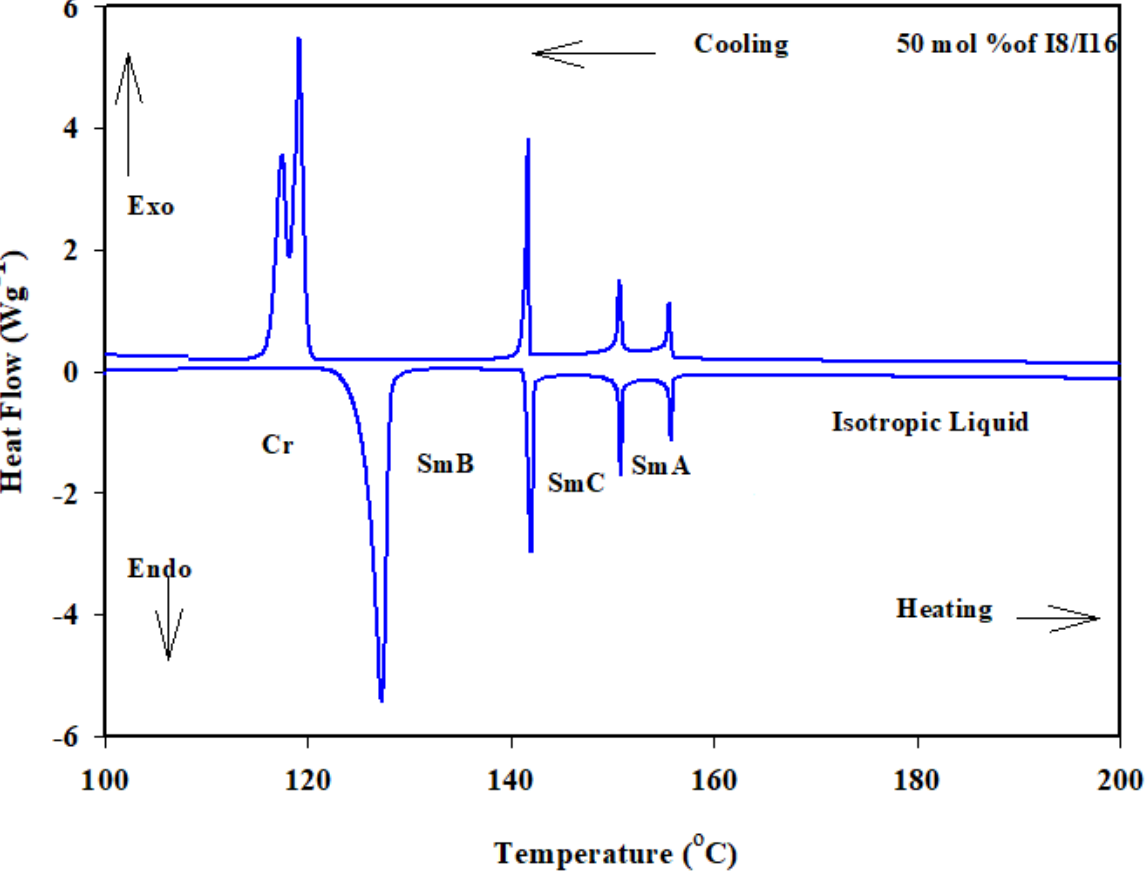
Figure 5. DSC thermogram for 50 mol% I8/I16 binary system during heating and cooling states at rate 10 °Cmin − 1 .